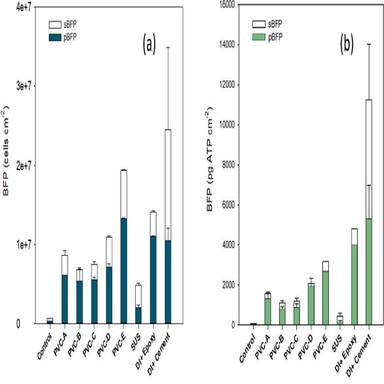
Biomass formation potential (BFP) of pipes: (a) Total cell count, (b) Adenosine triphosphate (ATP) level. The counts of planktonic cells (pBFP) and sessile cells (sBFP) were determined. Tests were conducted in duplicates. The error bars indicate standard deviation.